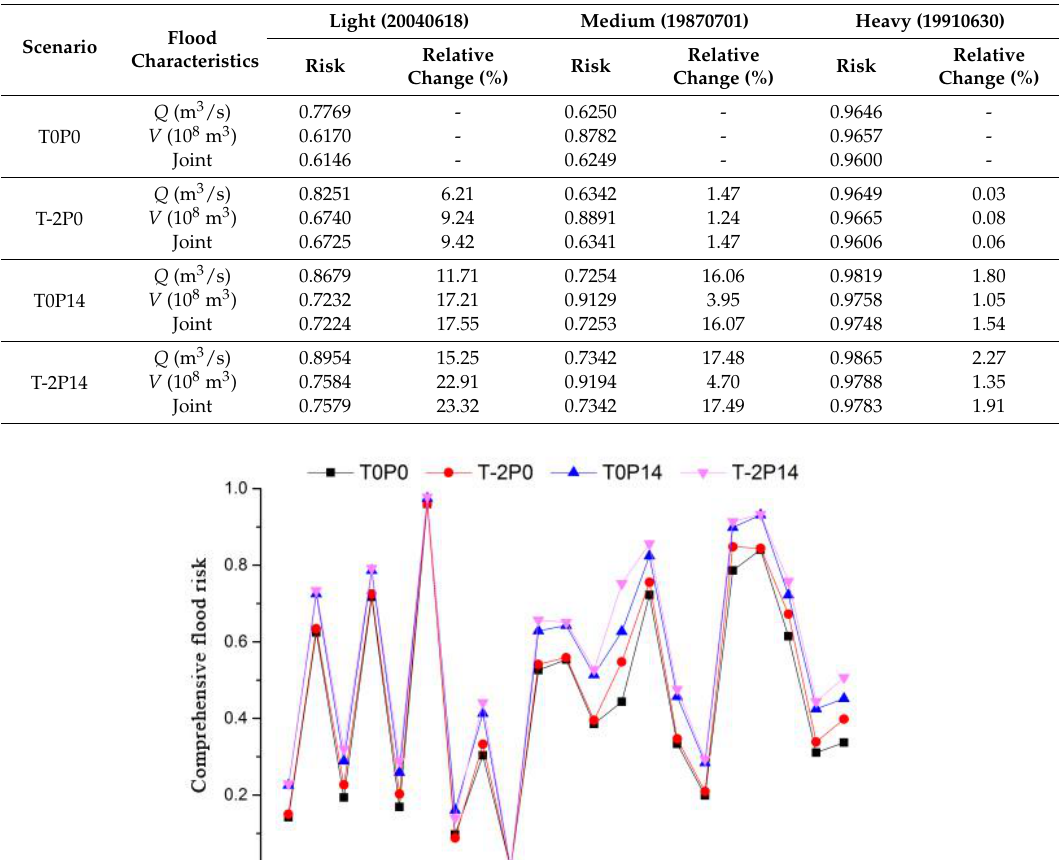
Table 10. The flood risk and their relative change for different-scaled floods.